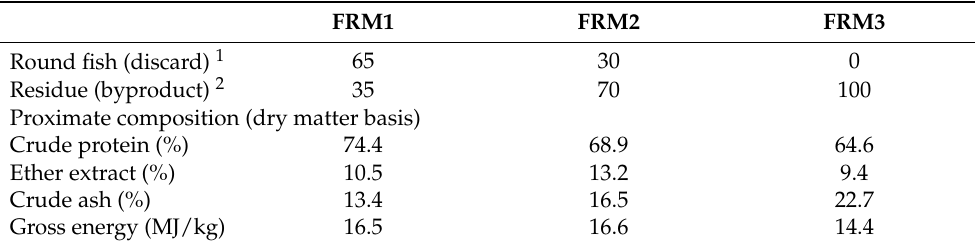
Table 3. Relative contribution (%) of whole-fish and fish residues in different residue meal, and their proximate composition used in Trials 2 and 3.